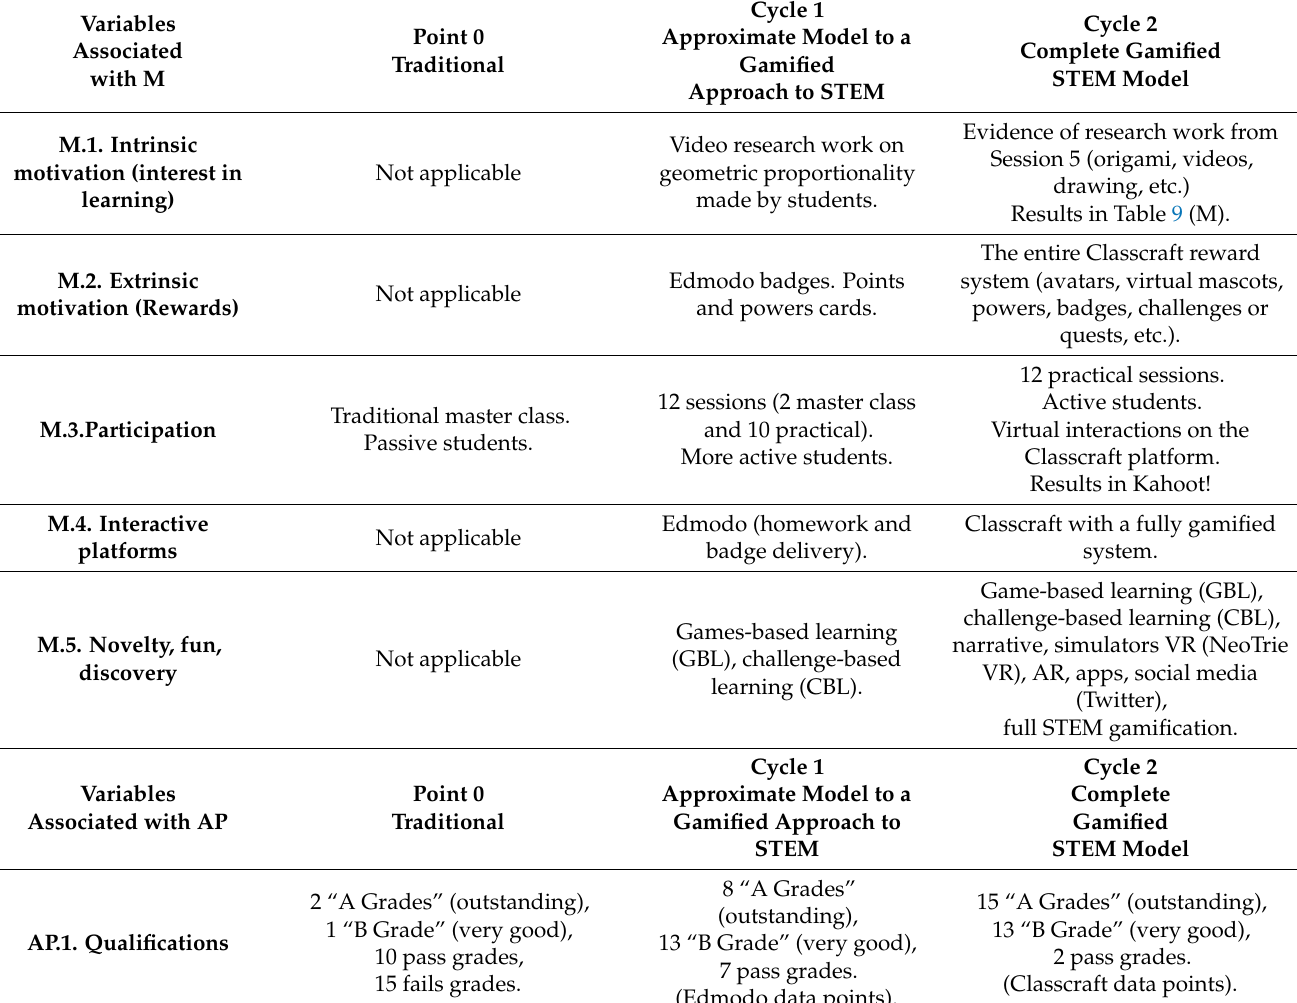
Table 11. Variables of the